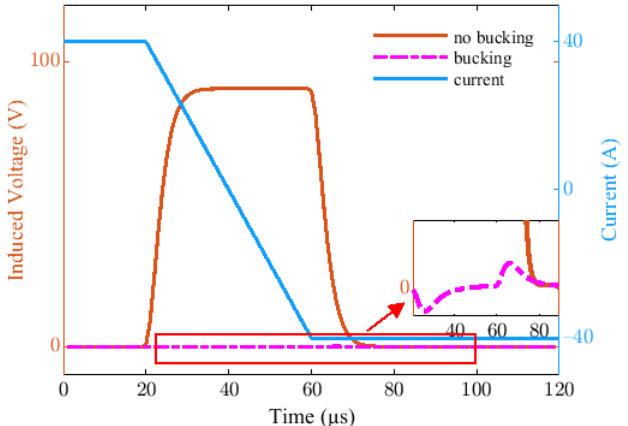
Figure 7. The received induced signals when the primary field signal is compensated or not com-